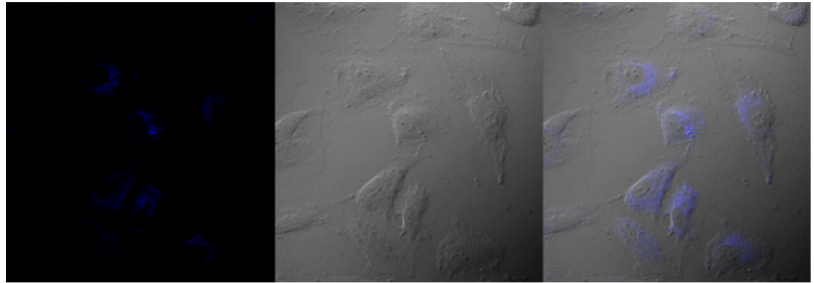
Figure 6. The cell cultured with 7.4 μ M Al 3+ daily for 3 days followed by normal culture for 5 days, then incubated with 5 μ M ITEC for 20 min.